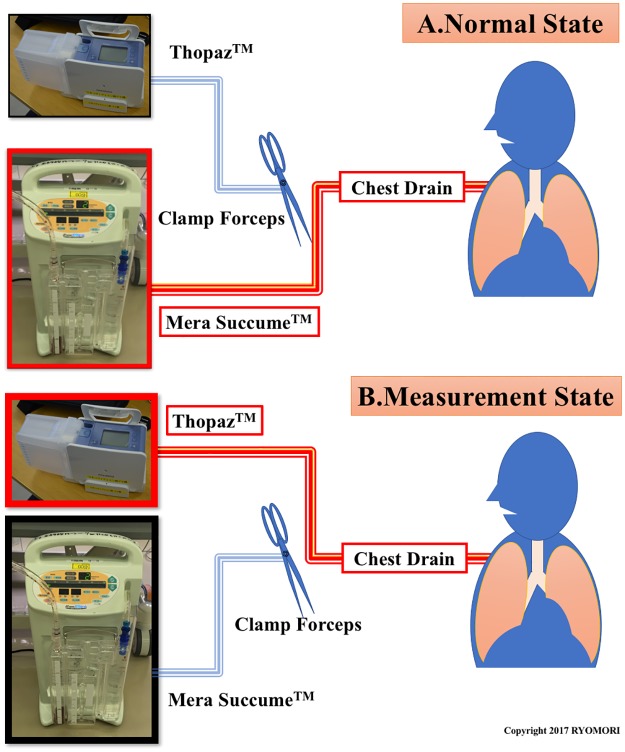
Connection and measurement of the ACS and DCS.(A) Normal state. (B) Measurement state.